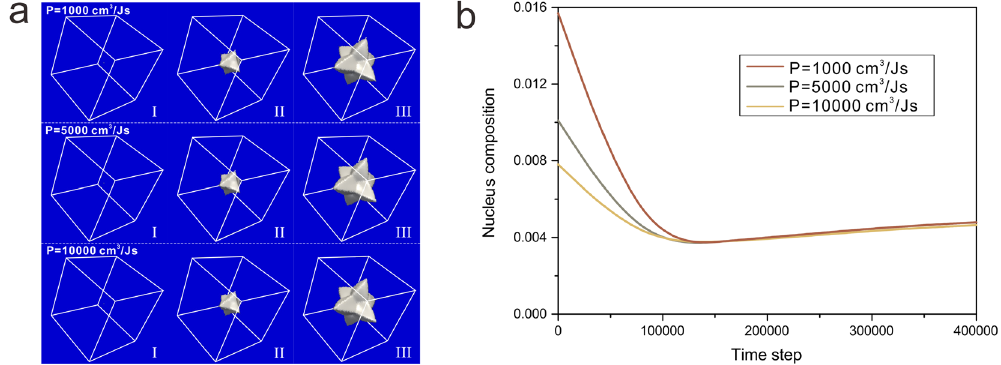
Figure 6. Grain growth evolution corresponding to different permeabilities during isothermal solidification ( a ) morphology evolution; ( b ) concentration evolution of the nucleus.